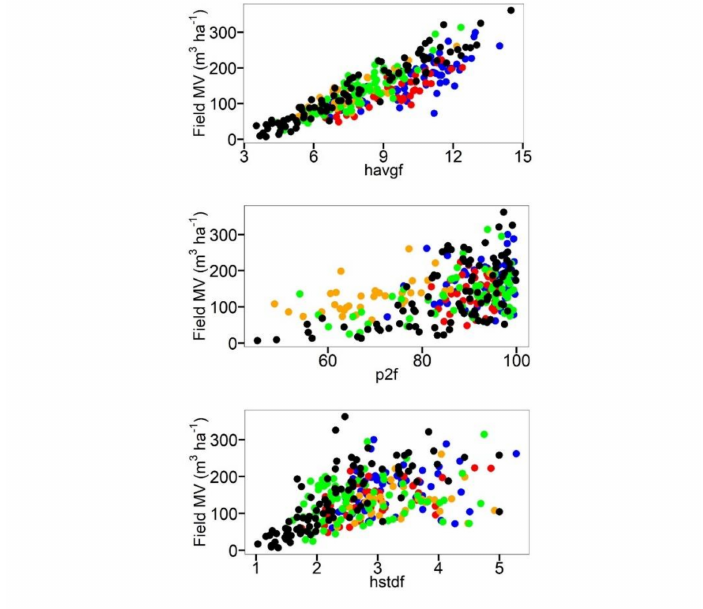
Figure 2. Scatter plots of the field merchantable volume (MV) against the explanatory variables. Field plots of each study site are represented by a dot. havgf = average height of first returns above 2 m; p2f = percentage of first returns above 2 m; hstdf = standard deviation of the height of first returns above 2